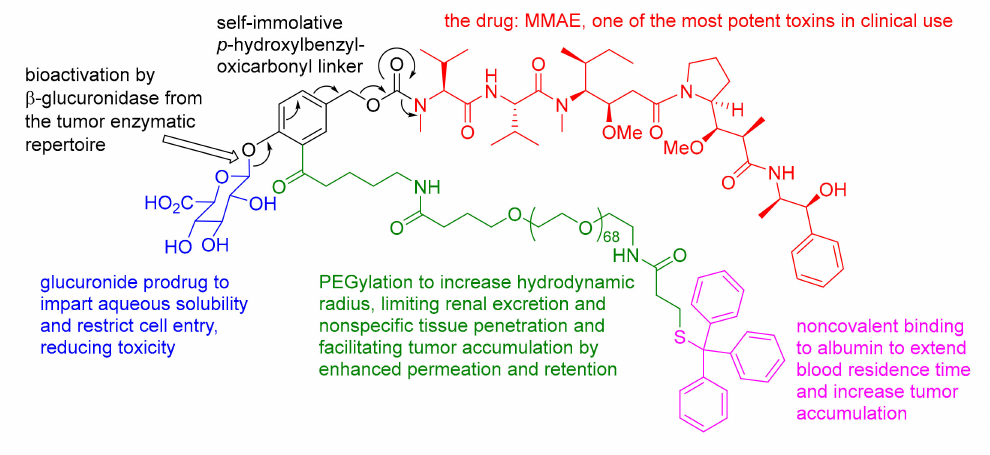
Figure 12. Chemical structure and mechanism of the bioactivation of the Tr-PEG glucuronide supramolecular MMAE